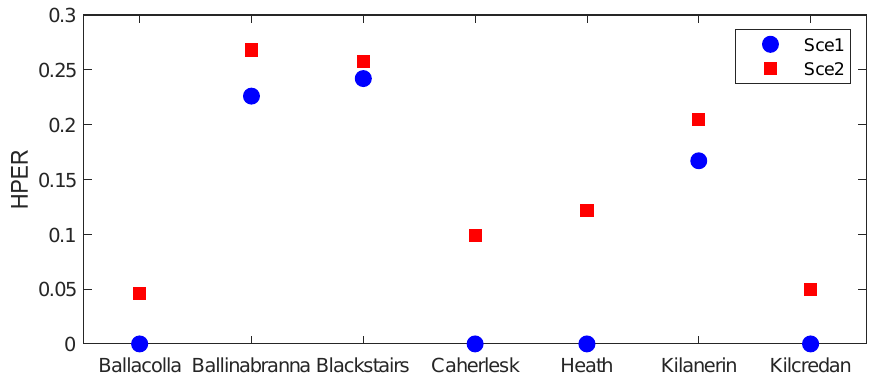
Figure 4. Hydropower potential indicator at each CORWSN in Scenario 1 and Scenario 2.